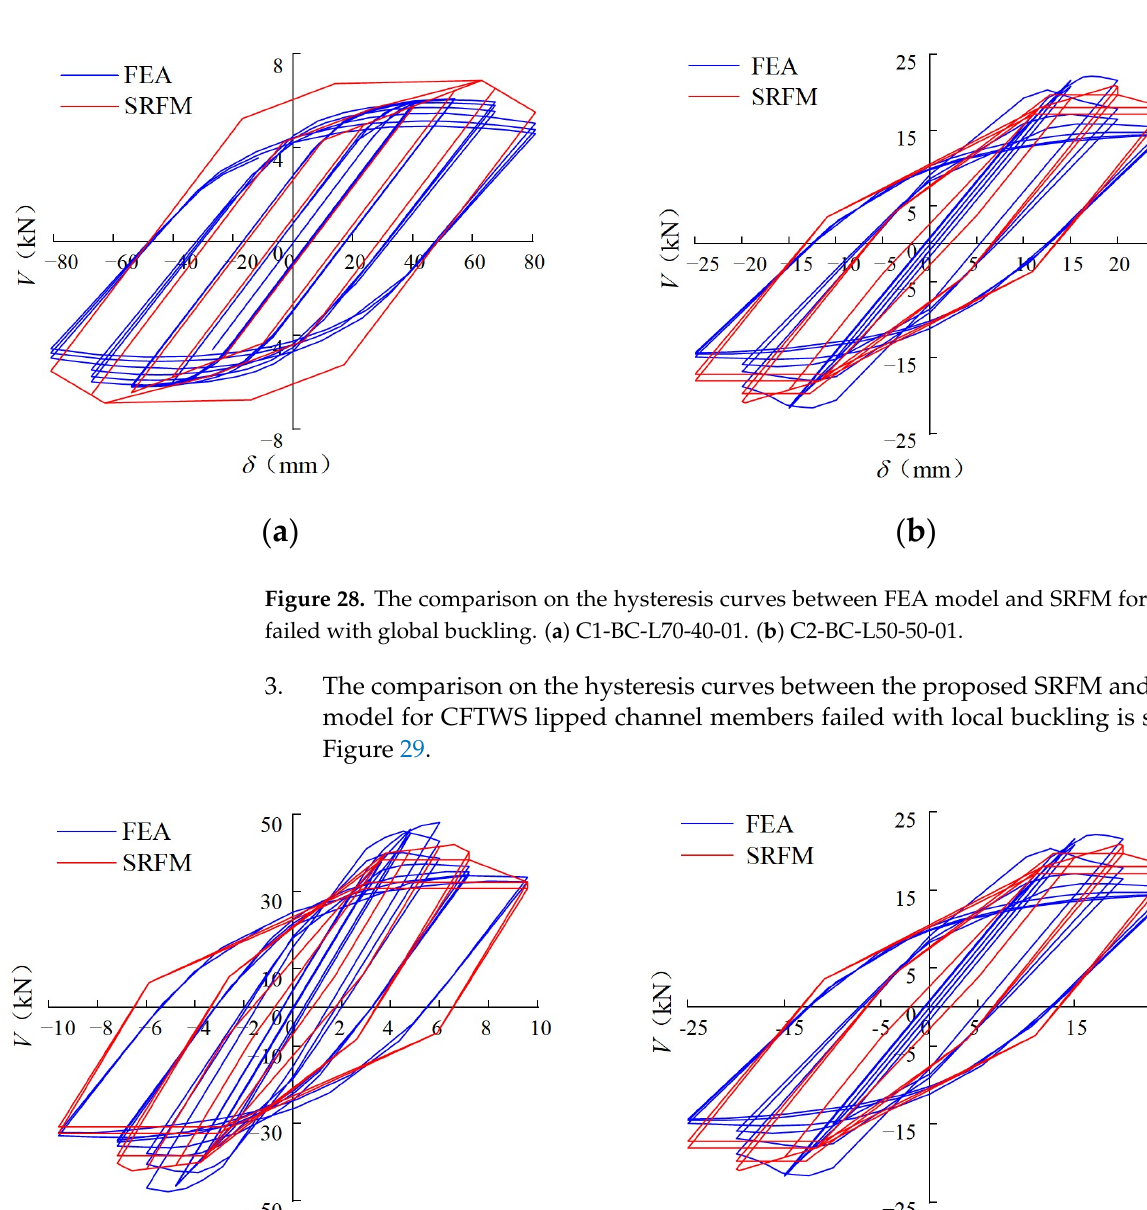
Figure 29. The comparison on the hysteresis curves between FEA model and SRFM for members failed with local buckling. ( a ) C4-BC-L15-70-02. ( b ) C4-BC-L30-70-02. 4. The comparison on the hysteresis curves between the proposed SRFM and the FEA model for CFTWS lipped channel members failed with distortional buckling is shown in Figure